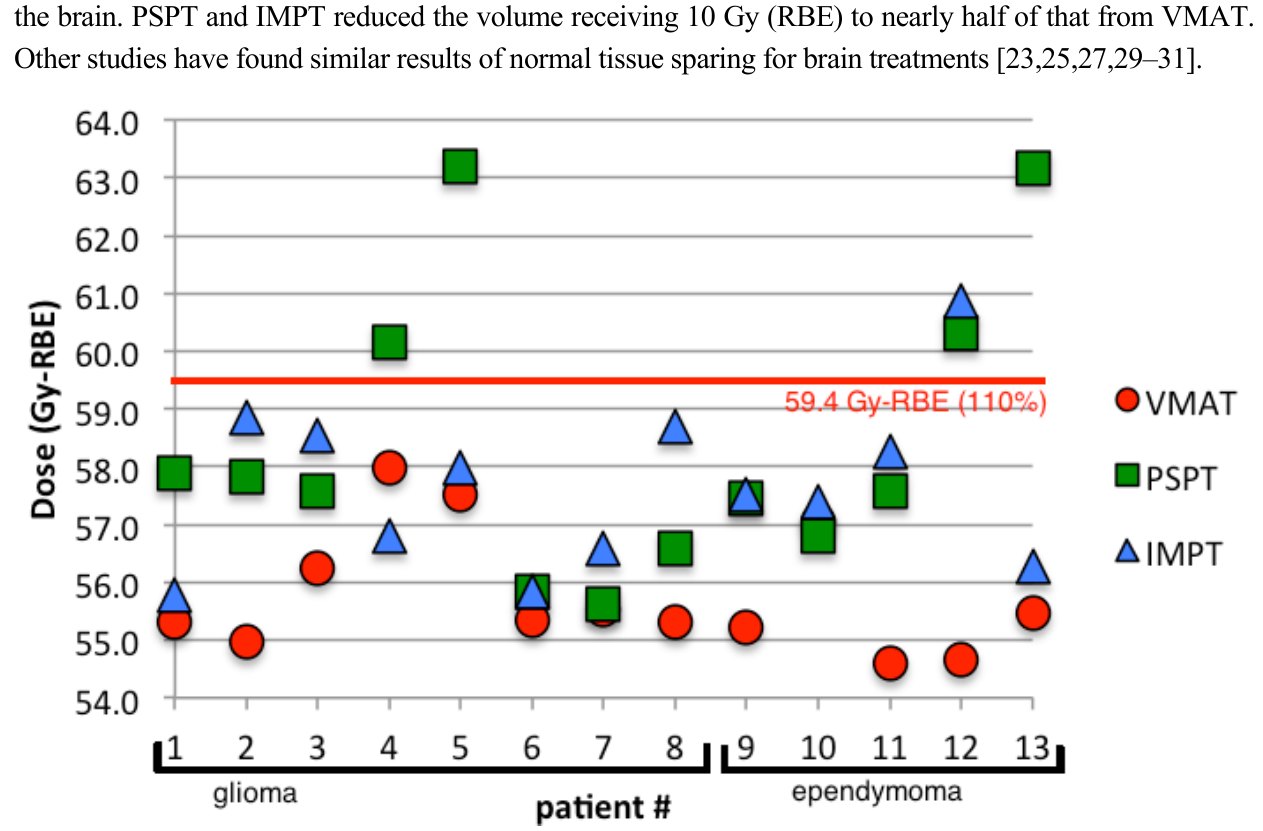
Figure 5. The maximum dose to the brain for VMAT, PSPT, and IMPT